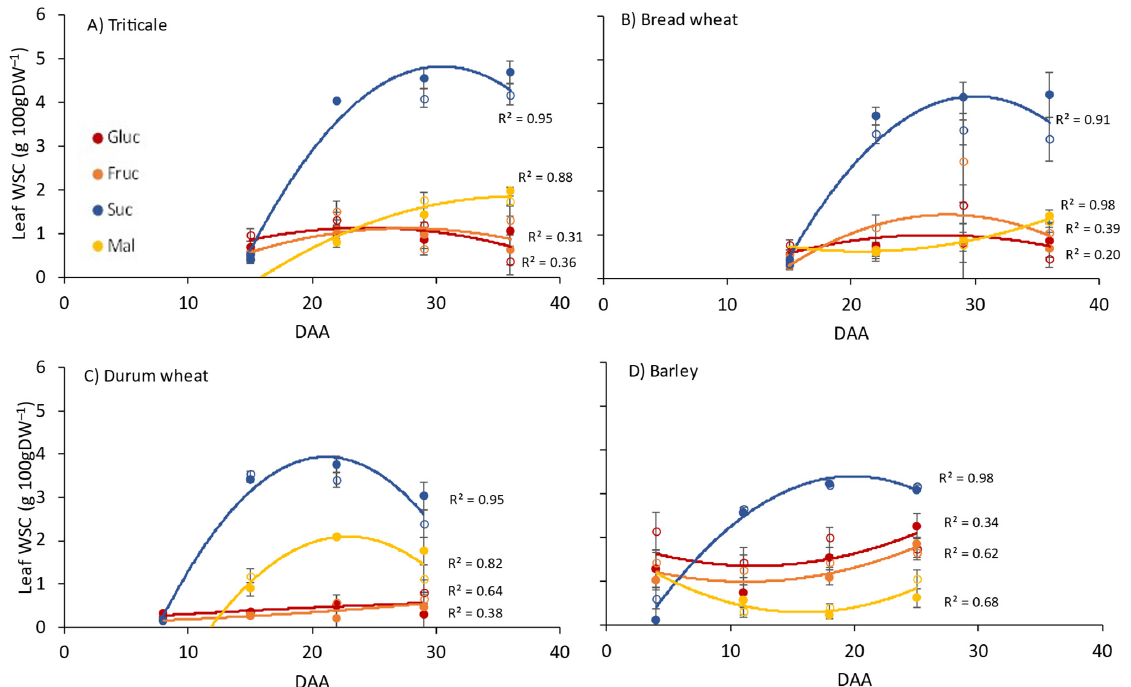
Figure 2. Time variation (expressed as days after anthesis, DAA) of the concentrations of different water-soluble carbo- hydrates (WSCs) (glucose, fructose, sucrose and maltose) (g 100 g DW − 1 ) in flag leaves in ( A ) triticale, ( B ) bread wheat, ( C ) durum wheat, and ( D ) barley under water-limited (open symbols) and well-watered (closed symbols) regimes. The regression equations are in Table